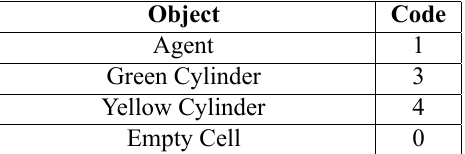
Table 1. Object’s code in the grid